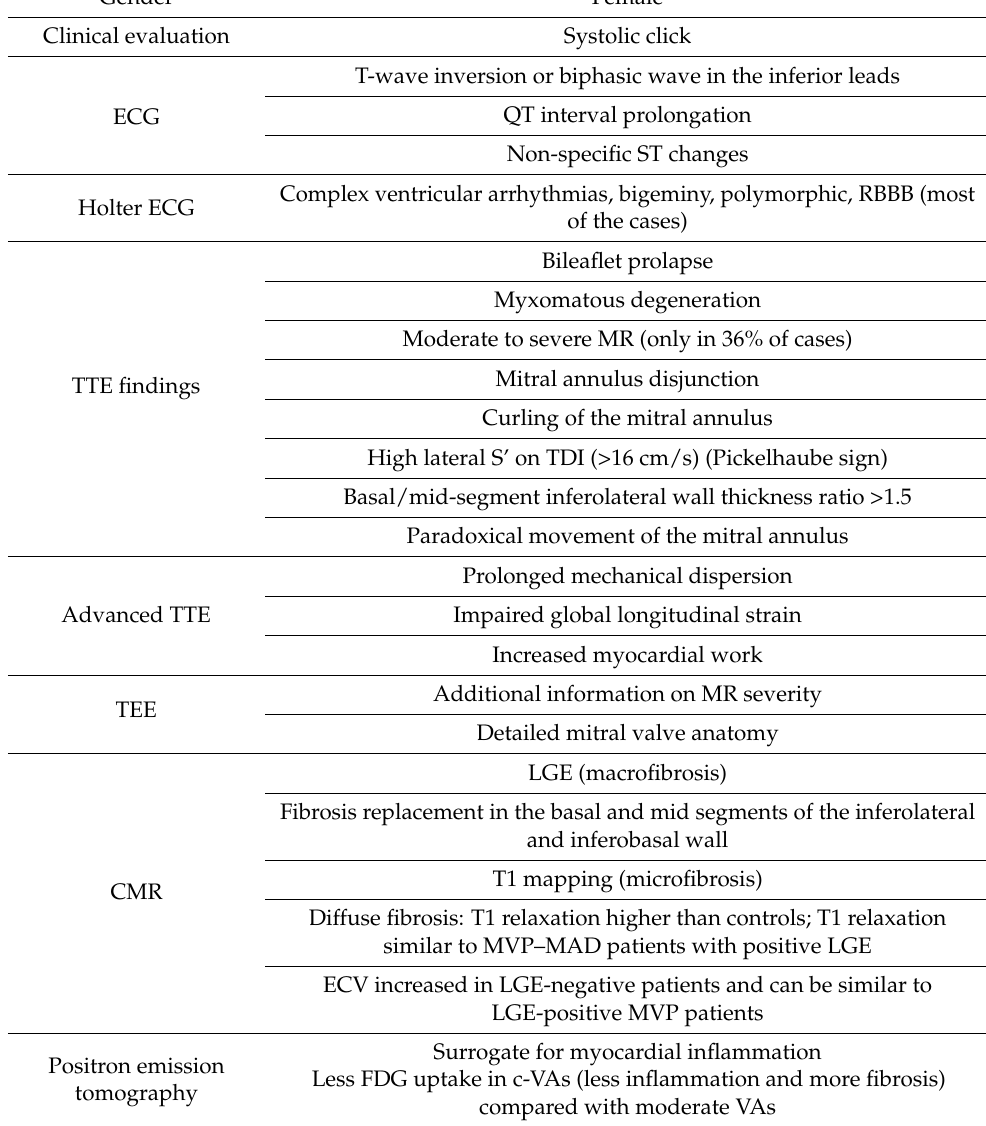
Table 1. Clinical, electrocardiographic, and multimodality imaging features of arrhythmic mitral valve